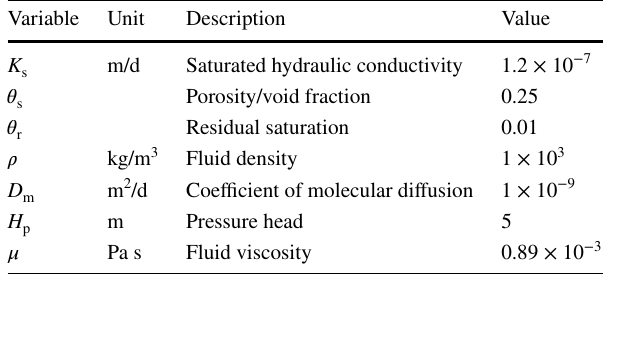
Table 3 Parameters of floor in the model